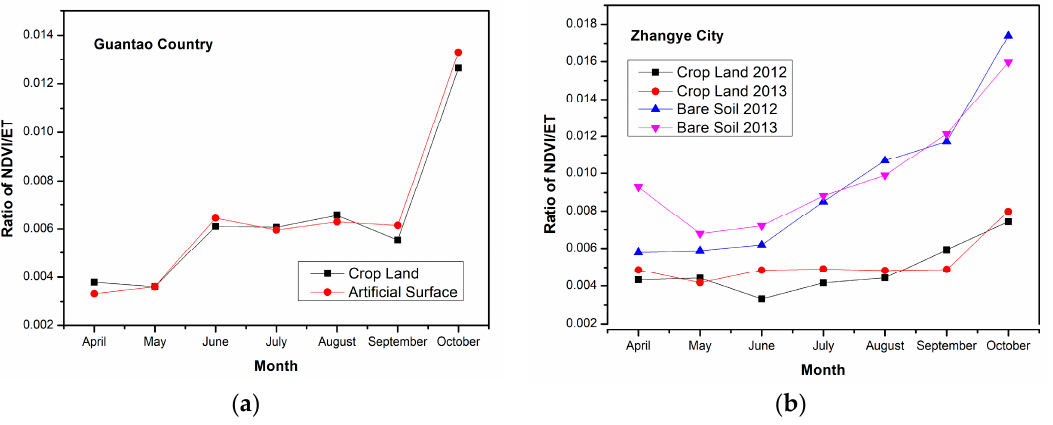
Figure 3. Comparisons of the ratio of NDVI/ET for the two main land cover types in ( a ) Guantao and ( b ) Zhangye.